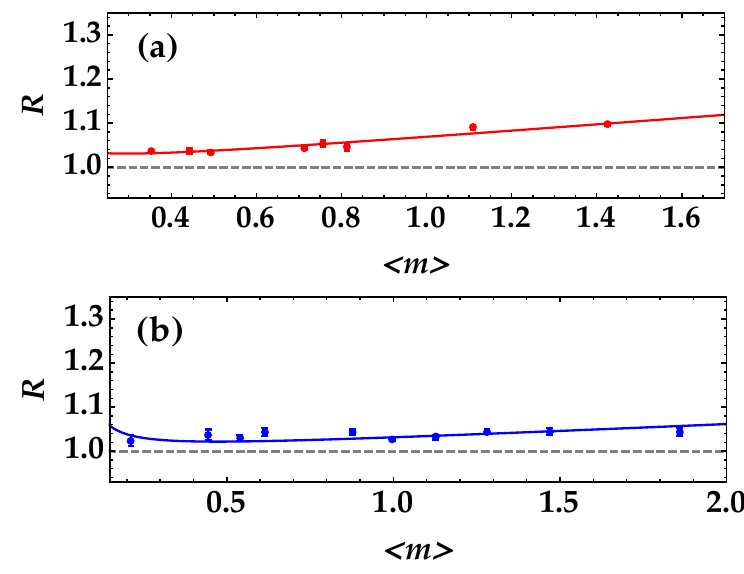
Figure 5. R as a function of the mean number of photons for µ = 2.8 ± 0.1 (Panel ( a )) and µ = 6.2 ± 0.3 (Panel ( b )). The data are shown as colored dots + error bars, while the theoretical curves according to Equation (8) are shown as colored lines. From the fitting procedure, we obtain the value of t . In particular, in Panel ( a ), t = 0.55 ± 0.02, and in Panel ( b ), t = 0.56 ± 0.03. The other parameters are (cid:104) m (cid:105) = 0.09 ± 0.03 and µ = 1.0 ± 0.1 in Panel ( a ) and (cid:104) m (cid:105) = 0.15 ± 0.03 and µ = 2.5 ± 0.3 in N N N N Panel ( b